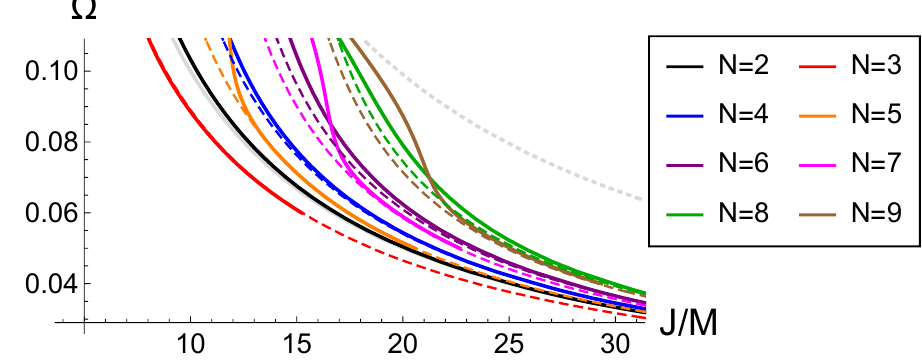
Figure 11 . Phase diagram of black ripples. The blob approximation (dashed) and the numerical result (solid) are compared. For reference, Myers-Perry black holes and Black bars are also plotted as gray dotted and solid curves. The numerical data are produced with the same method used in ref.